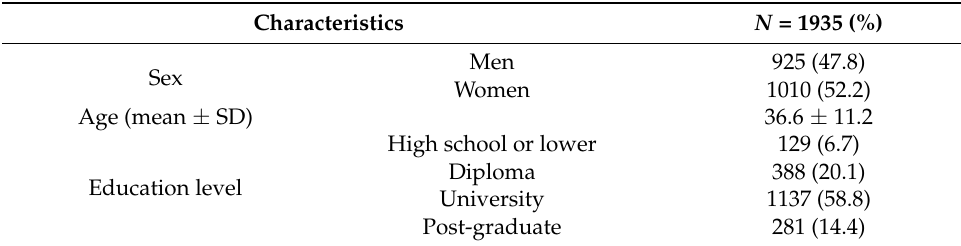
Table 1. Sociodemographic characteristics of the